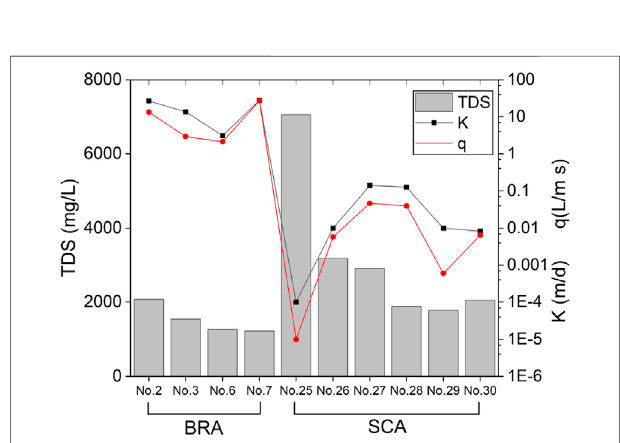
FIGURE 7 | TDS, hydraulic conductivity, and water yield of groundwater in BRA and SCA.